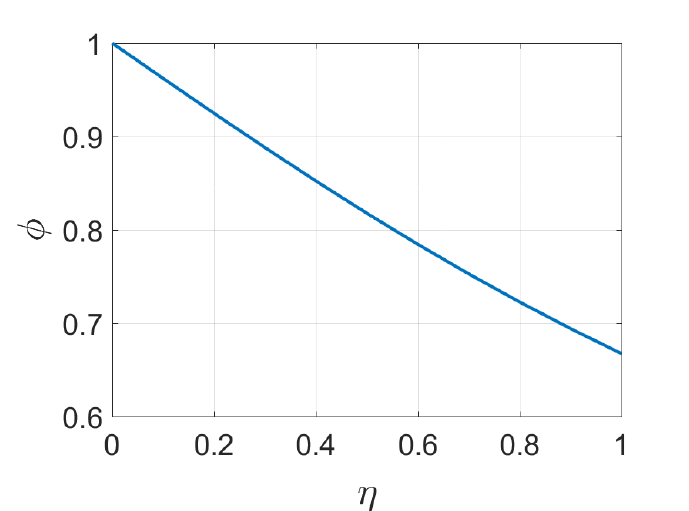
Figure 3. Concentration distribution.